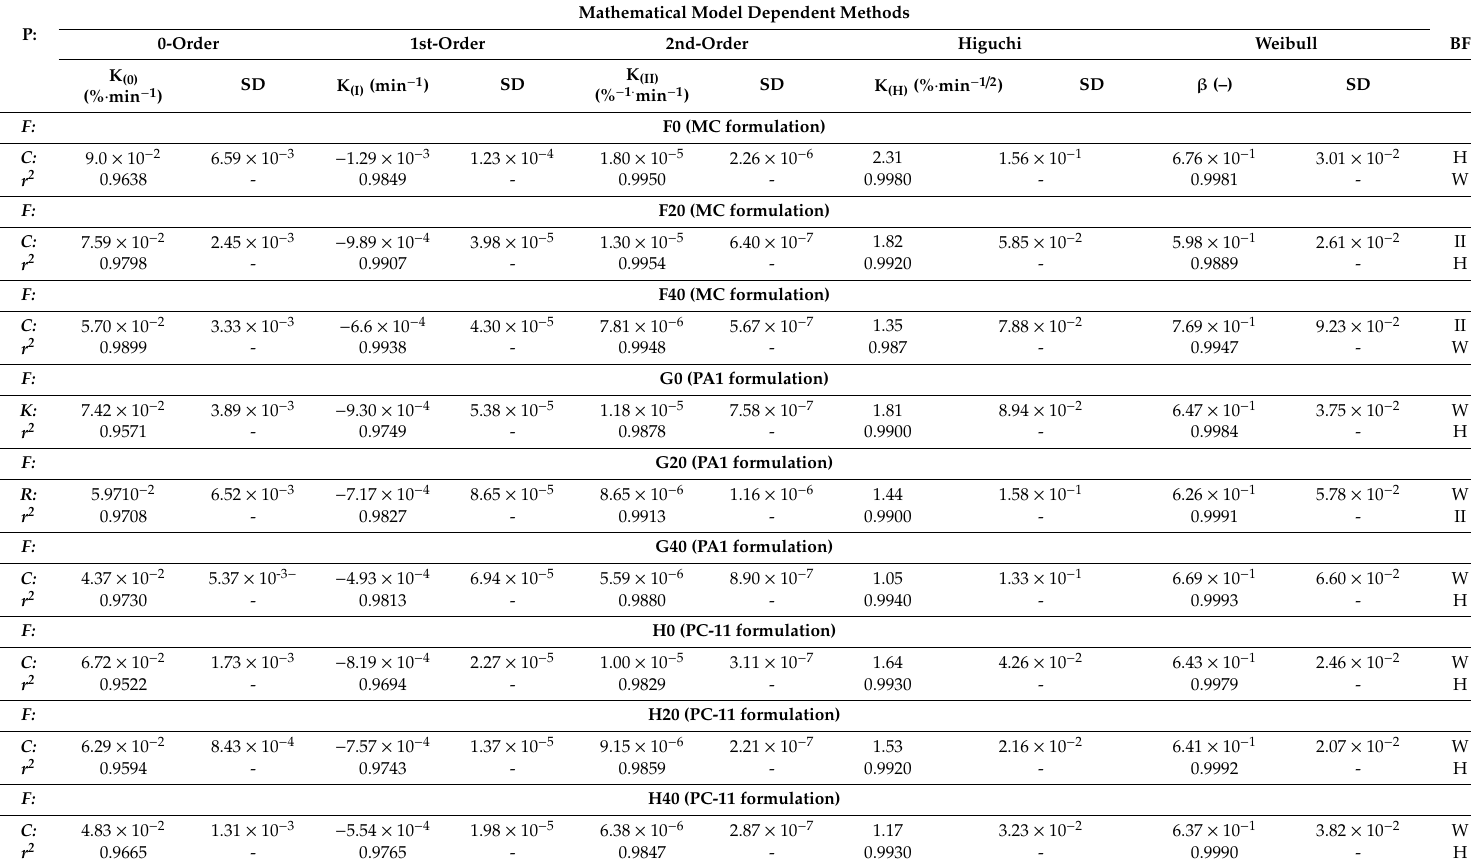
Table 3. The parameters determined in the course of release kinetics evaluation of gel formulations F, G, H, where K—release rates for respective model: zero-order kinetics (K (0) ), 1st-order kinetics (K (I) ), 2nd-order kinetics (K (II) ) and the Higuchi model (K (H) ), β —a shape parameter in the Weibull model, r 2 —correlation coefficient for the regression, SD—standard deviation, MC—methylcellulose, PA1—polyacrylic acid derivative (Carbopol 980 NF), PC-11—modified polyacrylic acid (Aristoflex